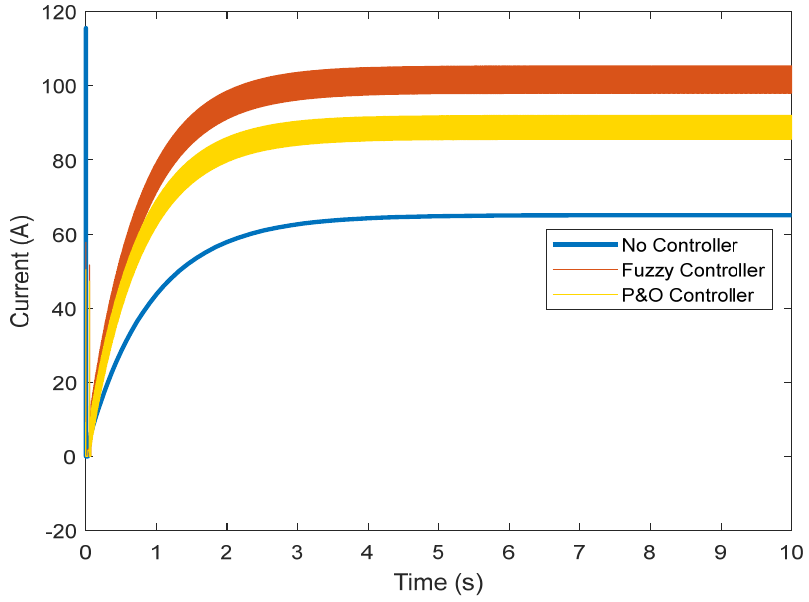
Figure 11. Output current of the fuel cell.